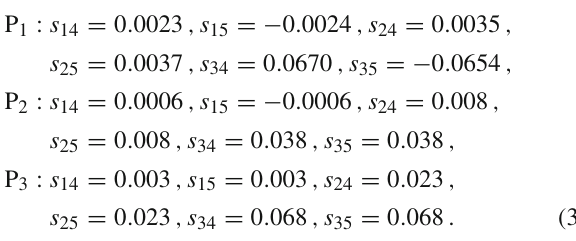
Fig. 16 General overview of cLFV observables (correlations) in the “3+2 toy model” parameter space. All active-sterile mixing angles, as well as Dirac and Majorana CP phases, are randomly varied (see detailed description in the text). In all panels, m 4 = 1 TeV, with m 5 − m 4 ∈ [ 40 MeV , 210 GeV ] . Blue points correspond to vanishing phases, while orange denote random values of all phases ( δ α and i = 4 , 5). Dotted (dashed) lines denote current bounds (future sensitivity) as given in Table 1 non-vanishing values of the phases (P (cid:3) i